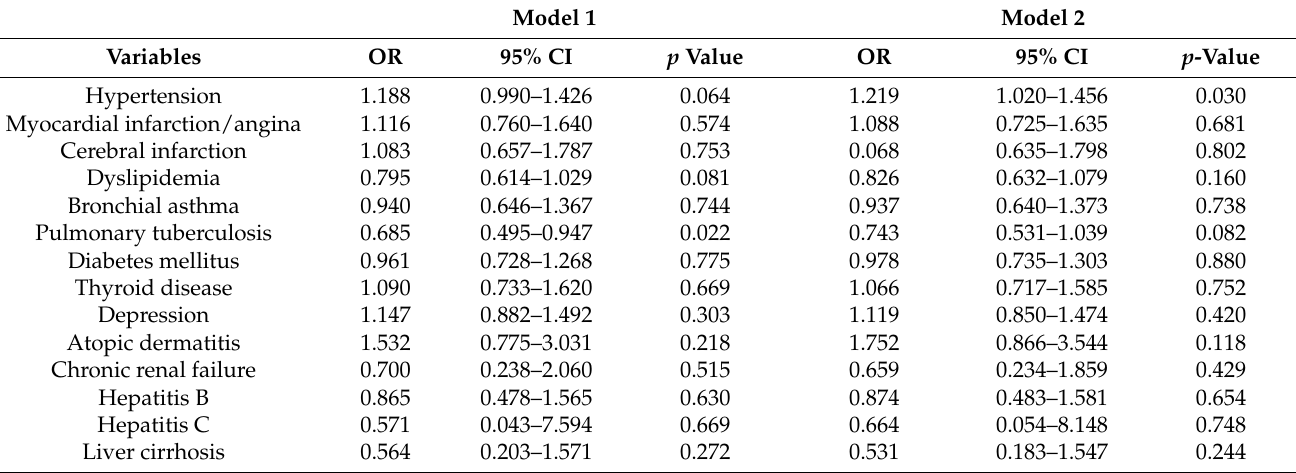
Table 2. Multivariate-adjusted ORs (95% CIs) for non-malignant comorbidities in spine OA compared to controls.